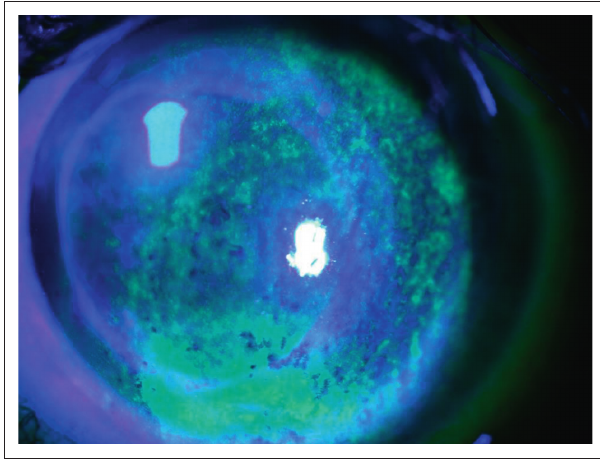
FIGURE 1: Extensive superficial punctate staining; this could be caused by benzalkonium chloride-exacerbated dry eye